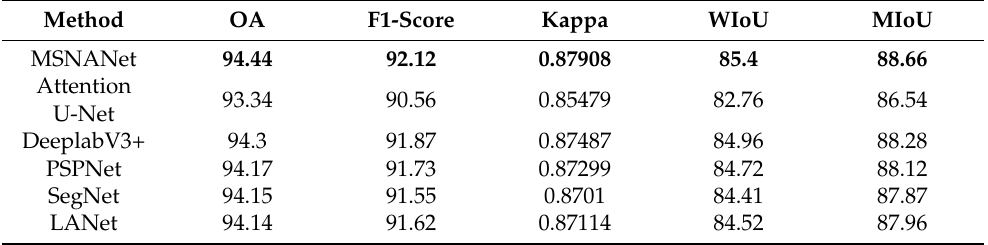
Table 2. Quantitative comparison for the SW dataset. Bold numbers indicate the best